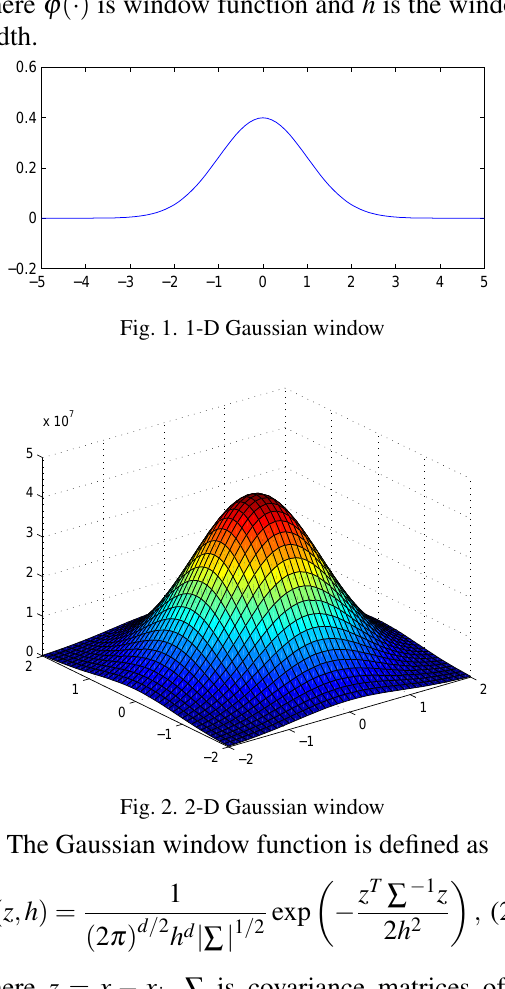
Fig. 2. 2-D Gaussian